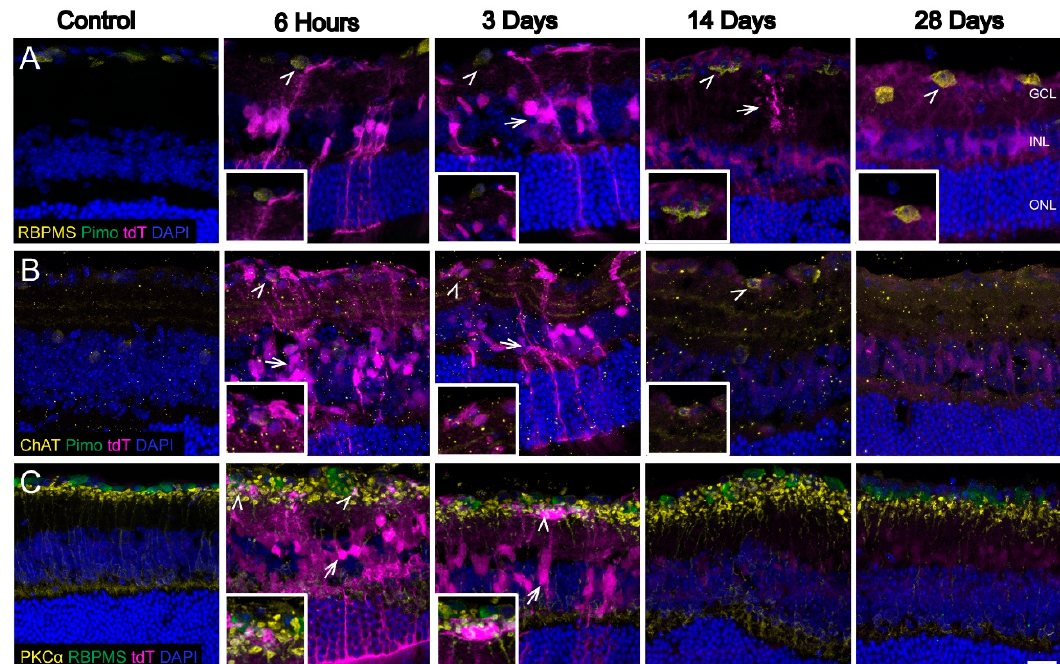
Figure 3. Hypoxic neurons in the retina after OHT. Sagittal retinal sections were labeled with neuronal markers ( A ). RBPMS (RNA binding protein multi-splicing, RGC marker-yellow, arrowhead) showed colocalization (arrowhead) with tdT in GCL. ( B ). ChAT (anti-choline acetyltransferase, amacrine cell marker, yellow) showed some colocalization with tdT. Arrows are pointing to tdT in Müller glia. Arrowhead is pointing at hypoxic amacrine cells at 6 h, 3 d, and 14 d. ( C ). PKC α (protein kinase c alpha, bipolar cell marker-yellow, arrowheads) showed some colocalization at 6 h and 3 d. RBPMS (shown in green in this panel). tdT (tdTomato) expression (magenta), DAPI (cell nuclei, blue). Retinal layers are labeled as follows: GCL (ganglion cell layer), INL (inner nuclear layer), and ONL (outer nuclear layer). Scale bar: 25 𝑢 m. n = 6 eyes at 6 h, 6 eyes at 3 d, 6 eyes at 14 d, 6 eyes at 28 d, and 10 control eyes. Insets represent a magnification of hypoxic neurons.